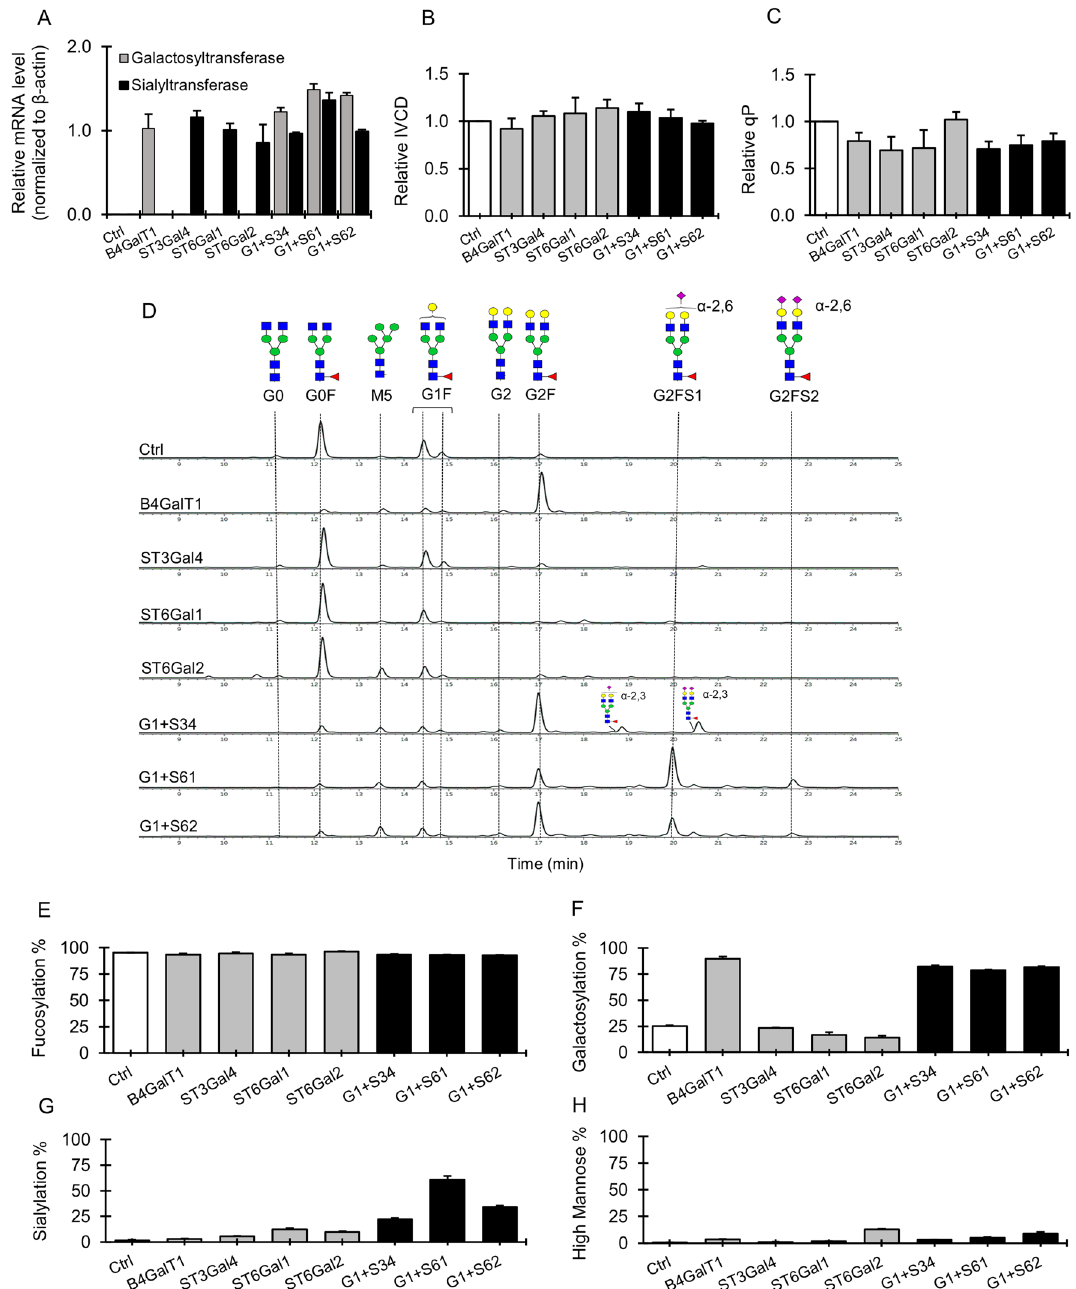
Figure 3. Impact of co-expressing B4GalT1 and sialyltransferase isoenyzmes on the growth, productivity and glycosylation of antibodies in stably transfected CHO cell pools. All stable pools were generated through RMCE. The control pools expressed IgG rituximab LC, HC and DsRed genes. Other stable pools expressed IgG rituximab LC and HC genes, B4GalT1 and ST6Gal1 either individually or in combination, and DsRed. G1 + S34, G1 + S61, G1 + S62 are combinatorial stable pools co-expressing B4GalT1 and either of ST3Gal4, ST6Gal1 and ST6Gal2 gene, respectively. All stable pools were characterized in 7-day fed-batch cultures. ( A ) Relative galactosyltransferase/ sialyltransferase transcript levels in different stable pools to the internal control, β-actin (ACT) as determined by quantitative real time-PCR (qRT-PCR). ( B – C ) Relative change in the integrated viable cell density (IVCD) and specific productivity (qP) of each stably transfected pool to the control. ( D ) Aligned HILIC chromatograms of N-linked glycans on antibodies in different stable pools. Chromatograms shown are one of biological replicates with similar results. ( E – H ) Relative distribution of fucosylation, galactosylation, sialylation and high-mannose on antibodies produced different stable pools. Each point represents the average and standard deviation of measurements from two independent stably transfected